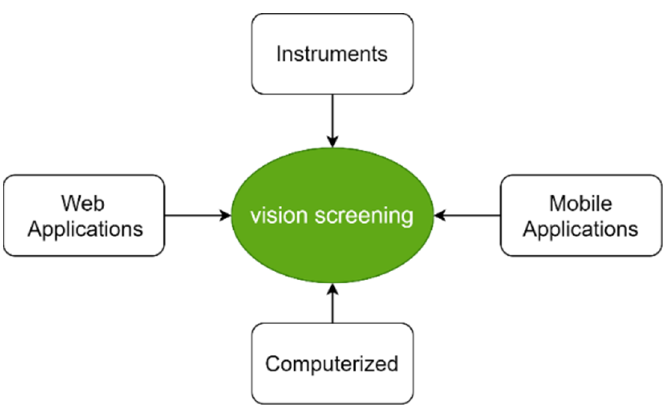
Figure 3. Different paradigms of technologies assisting experts in vision screening.